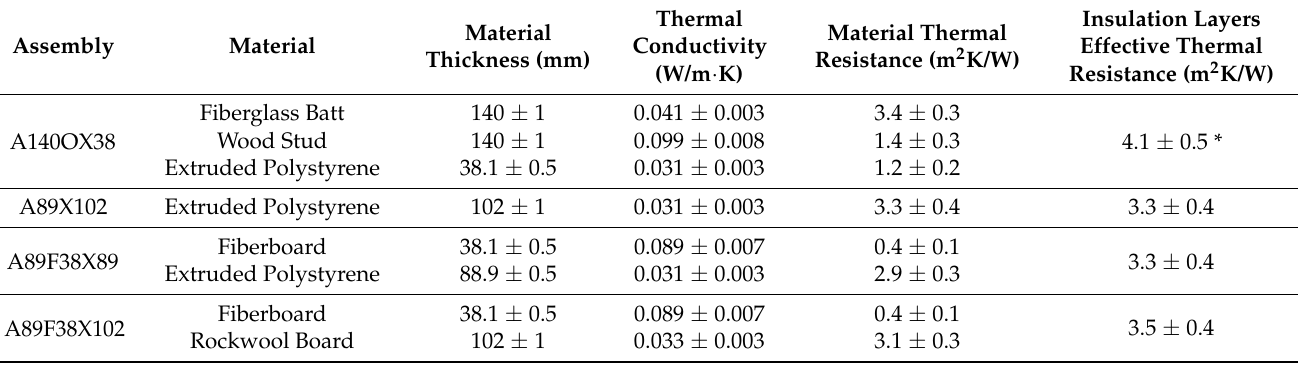
Table 4. The effective thermal resistance of the whole wall, the thermal resistance of the insula- tion materials and the thermal conductivity, as measured in the laboratory using a FOX 314 heat flow